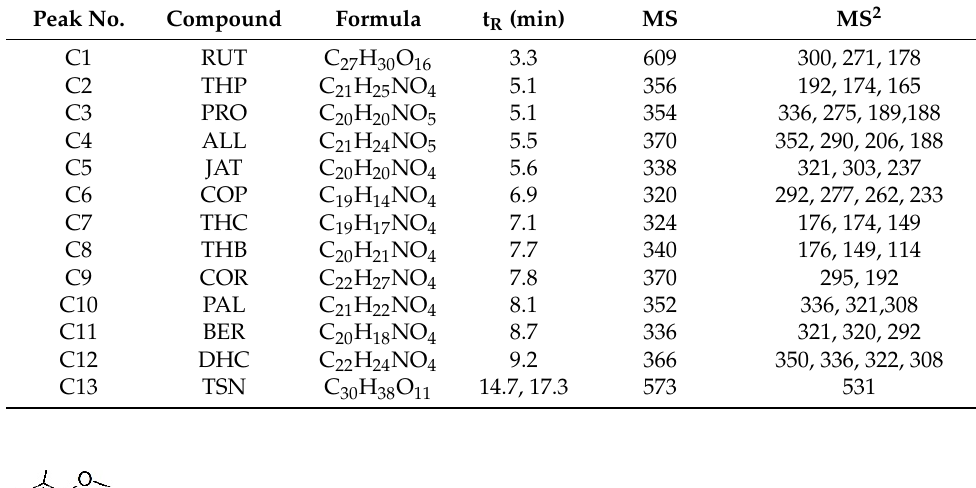
Table 1. Retention time (t R ) and MS 2 fragment ions of thirteen components identified in JLZS.